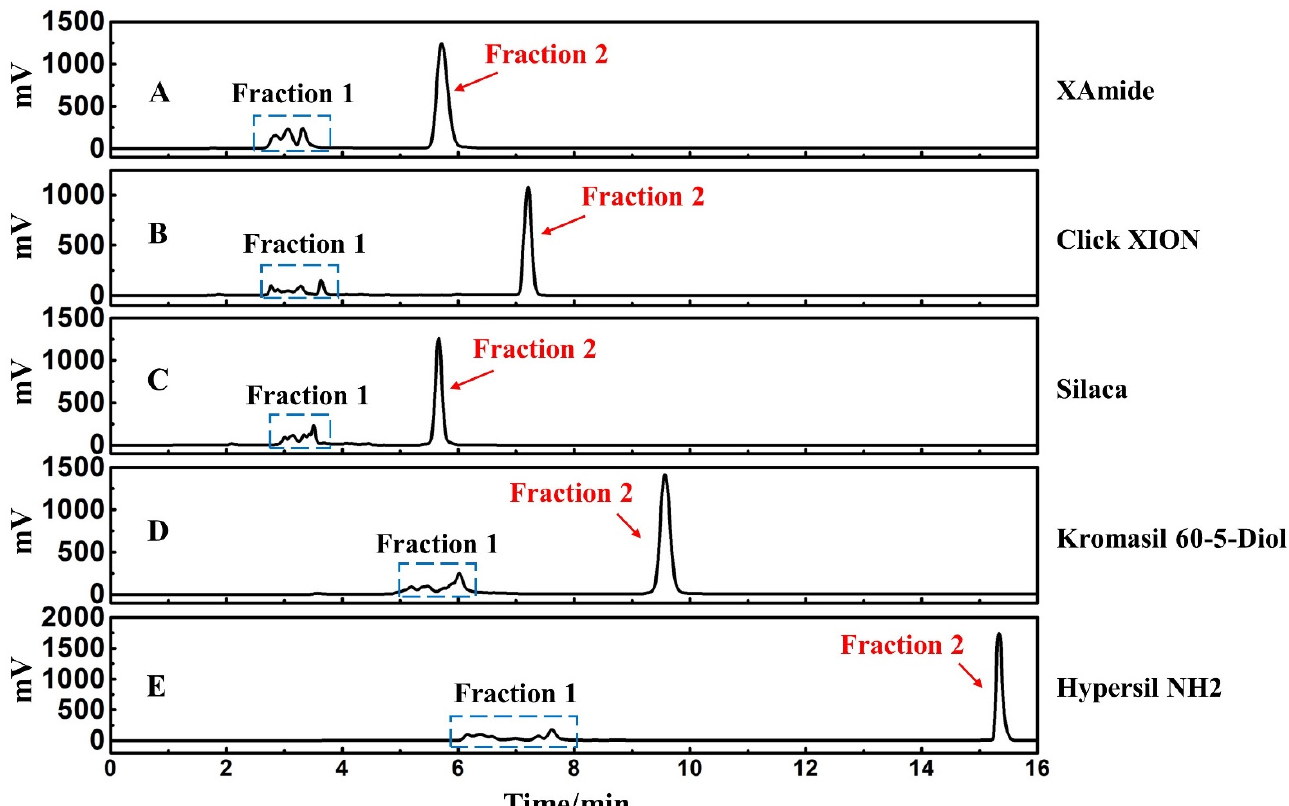
Figure 1. HPLC analysis of crude sample on five representative chromatography columns (( A ): XAmide, ( B ): Click XION, ( C ): Silica, ( D ): Kromasil 60-5 Diol, and ( E ): Hypersil NH 2 ) under normal phase mode; injection volume: 1.0 μ L. Conditions: isocratic elution: 0–16 min, 100% dichloromethane; monitoring wavelength: 270 nm; flow rate: 1.0 mL/min; column temperature: 30 °C.